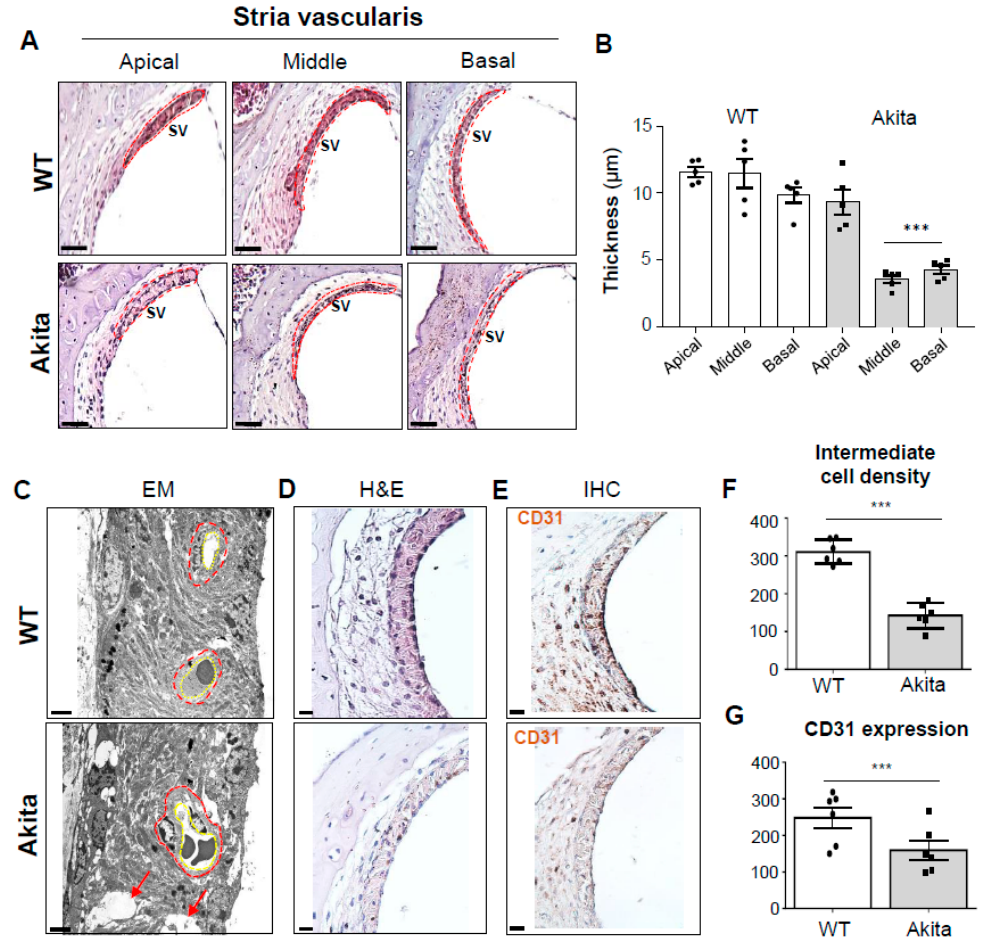
Figure 3. Comparative study of the stria vascularis (SV) in WT and Akita mice. ( A ) H&E-stained sections from the SV (red dotted line) in the apical, middle, and basal turns of the cochlea. Scale bars, 50 µ m. ( B ) Graph representing the quantification of SV thickness in the apical, middle, and basal turns of WT and Akita mice. Individual circles represent individual mice ( n = 5, for each group). ( C ) TEMs of WT and Akita (at the mid-turn) mice showing the blood-labyrinth barrier (BLL) (red dotted line), capillary pores (yellow dotted line), and intermediate cells with cavities (red arrow) throughout the SVs. Scale bars, 2 µ m. ( D ) H&E staining of intermediate cell density and ( E ) CD31 immunostaining of the vascular endothelial cells in the SV of the mid-turns in WT and Akita mice. Scale bars, 20 µ m. ( F ) Intermediate cell density and ( G ) chromogenic intensity of CD31 quantified by image J analysis are shown for both WT ( n = 6) and Akita ( n = 6) mice. Results are means ± SEM. *** p < 0.001 by Student’s t -test.